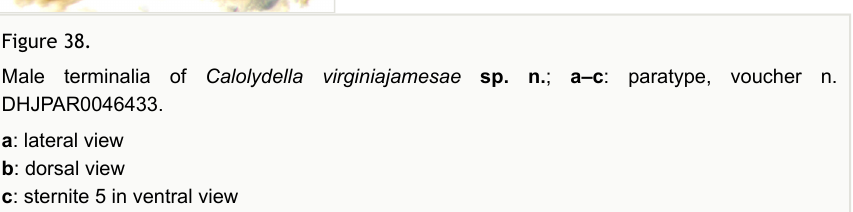
Female (Fig. 37d, e, f). Length: 4–7mm. Fronto-orbital plate 2.1X wider than in male. Diagnosis Calolydella virginiajamesae can be distinguished from all other species of Calolydella by the following combination of traits: fronto-orbital plate with a single row of small black setulae outside of frontal setae, parafacial silver-pollinose, anatergite with three or more setae arranged in a small tuft, and T3–T4 each with a single pair of discal setae.